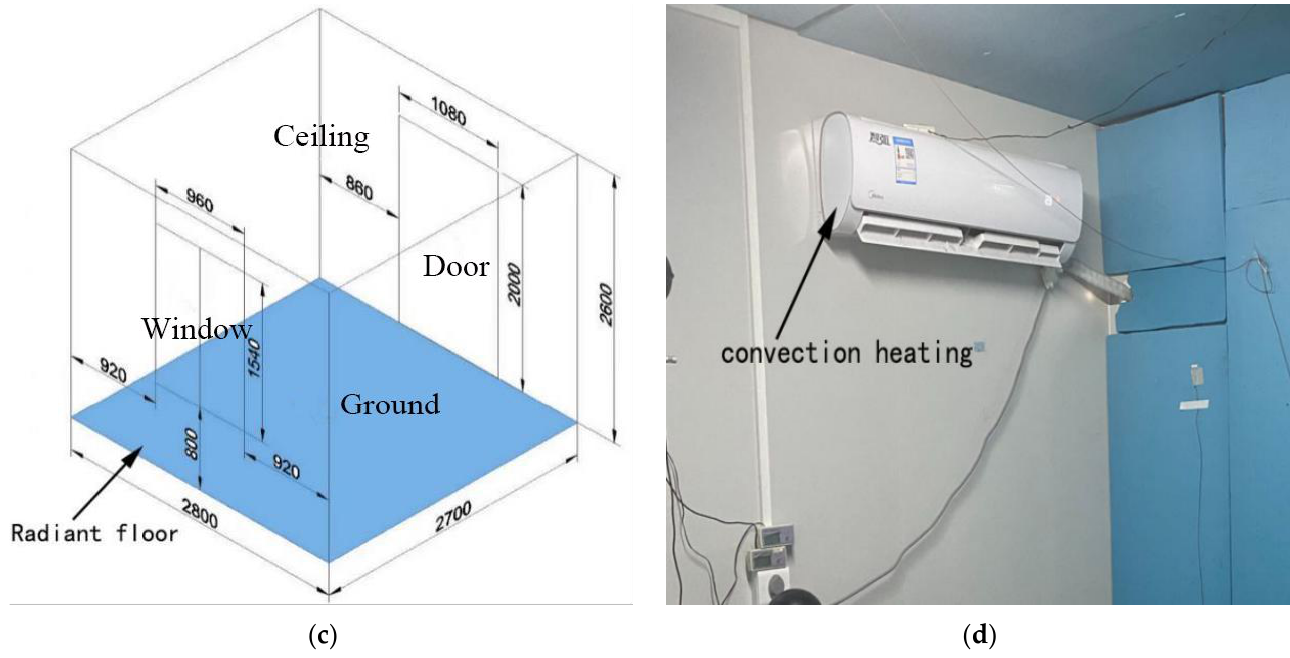
Figure 1. ( a ) Climate chamber schematic diagram. ( b ) Shaded window in the climate room. ( c ) Radiant floor heating and ( d ) convection heating for wall-mounted air conditioners.